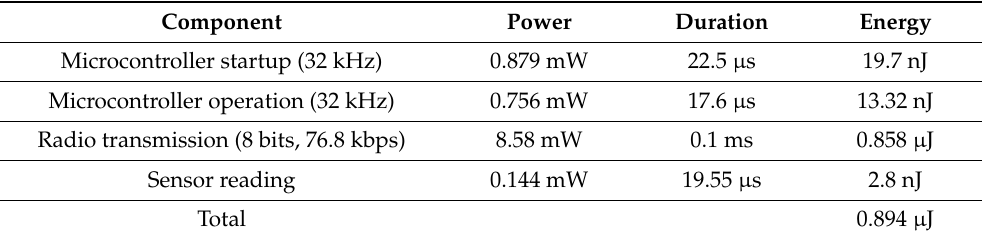
Table 2. Transmitter circuit subsystem energy consumption at different program states.